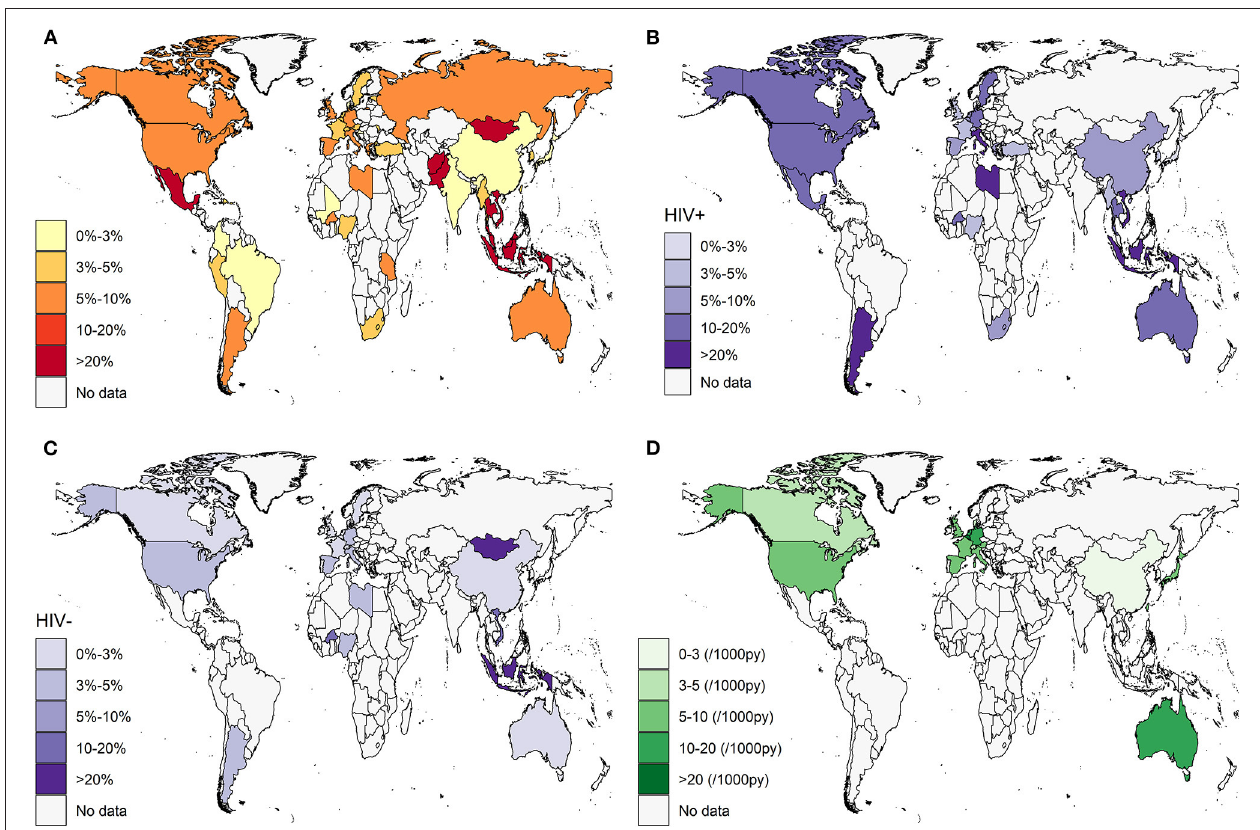
FIGURE 2 | Estimated HCV prevalence and incidence in MSM by country. (A) HCV prevalence in overall MSM population; (B) HCV prevalence in HIV-positive MSM subpopulation; (C) HCV prevalence in HIV-negative MSM subpopulation; (D) HCV incidence in overall MSM population. White area indicated no data available. HCV, hepatitis C virus; MSM, men who have sex with men.